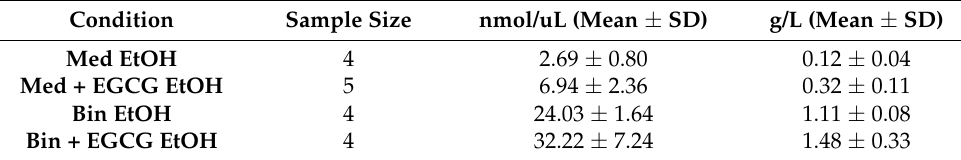
Table 1. Blood alcohol concentrations for the various experimental conditions. Condition Sample